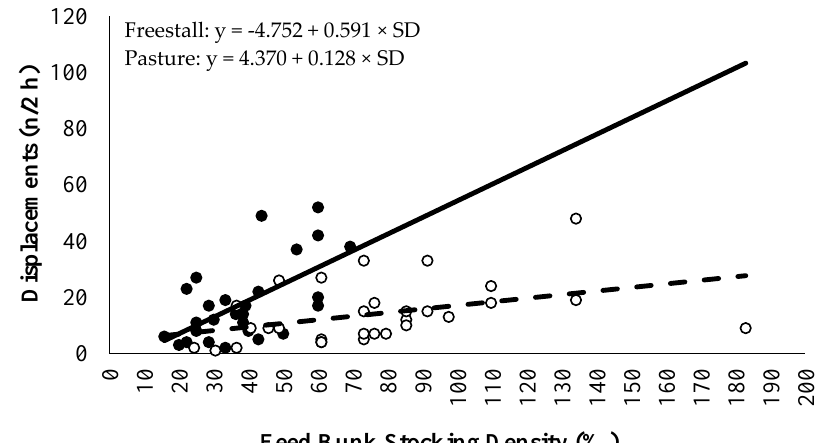
Figure 8. Model for number of feed bunk displacements during the 2 h period immediately after fresh feed delivery for freestall (solid line and closed circles; n = 14) and pasture (dashed line and open circles; n = 14) treatments ( p = 0.01) by stocking density (SD).